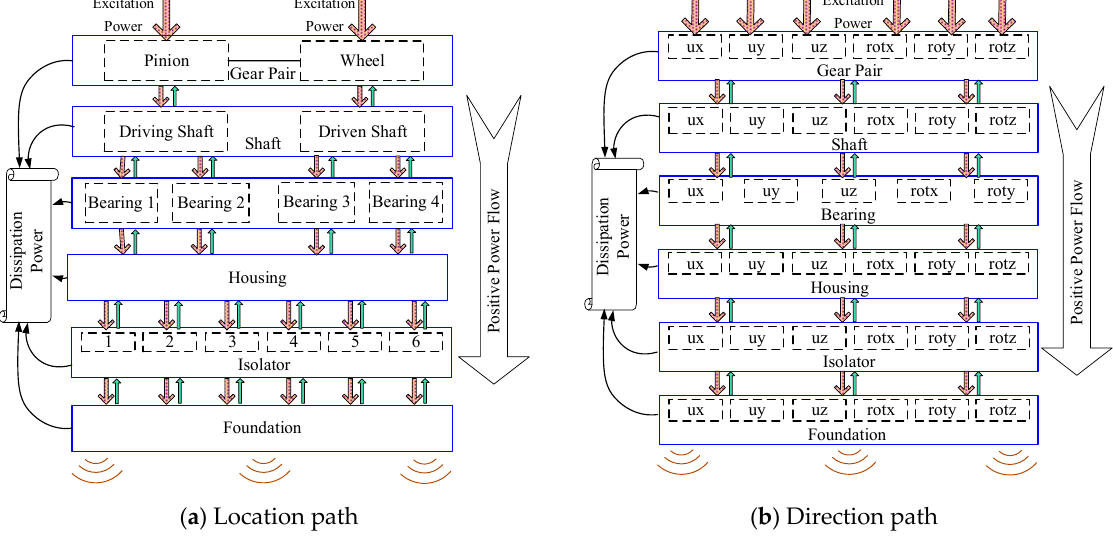
Figure 6. Layering transfer path.